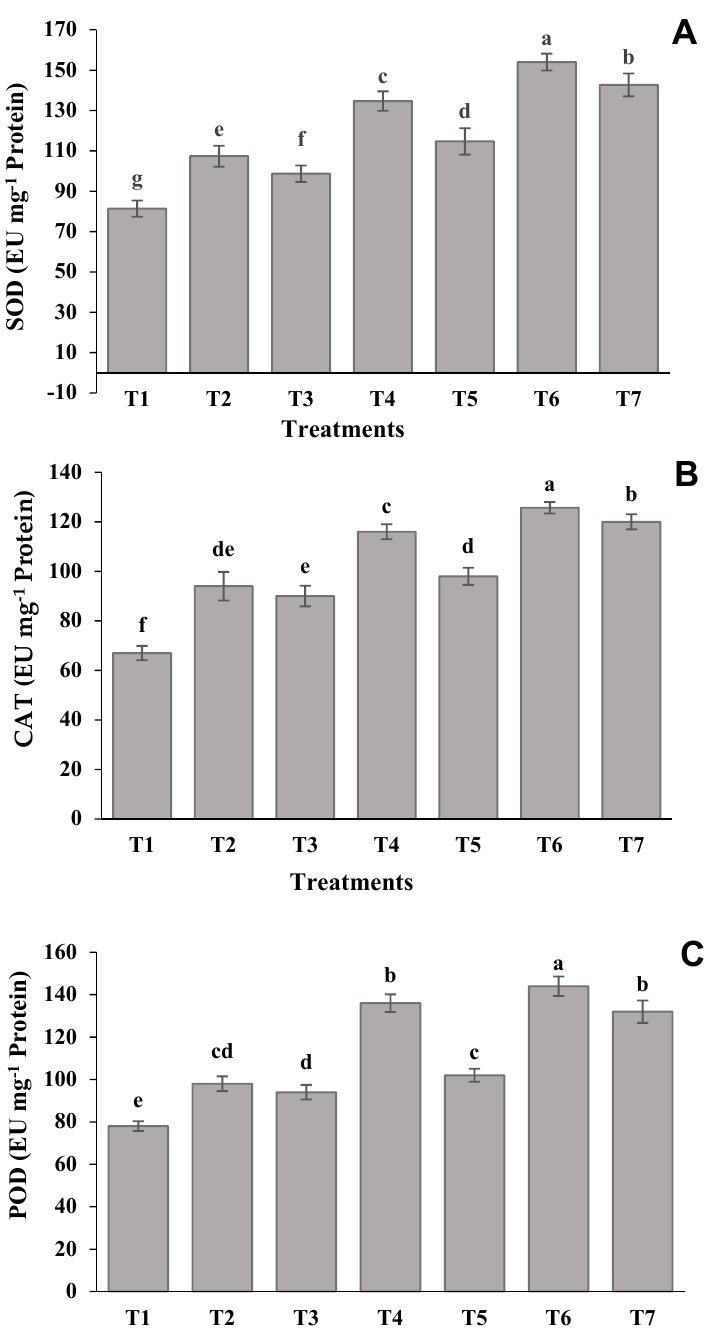
Figure 2. Effect of SNP on the antioxidant enzymes activity ( A ) SOD, ( B ) CAT, and ( C ) POD in leaves of lentil plants under salinity stress. Data presented are the means ± SE ( n = 4). Different letters on the bars indicate significant differences among the treatments at p ≥ 0.05 for individual antioxidant enzymes. T1 = 0 mM of NaCl + 0 µ M of SNP (control); T2 = 50 mM of NaCl + 0 µ M of SNP; T3 = 100 mM of NaCl + 0 µ M of SNP; T4 = 50 mM of NaCl + 50 µ M of SNP; T5 = 100 mM of NaCl + 50 µ M of SNP; T6 = 50 mM of NaCl + 100 µ M of SNP; T7 = 100 mM of NaCl + 100 µ M of SNP.